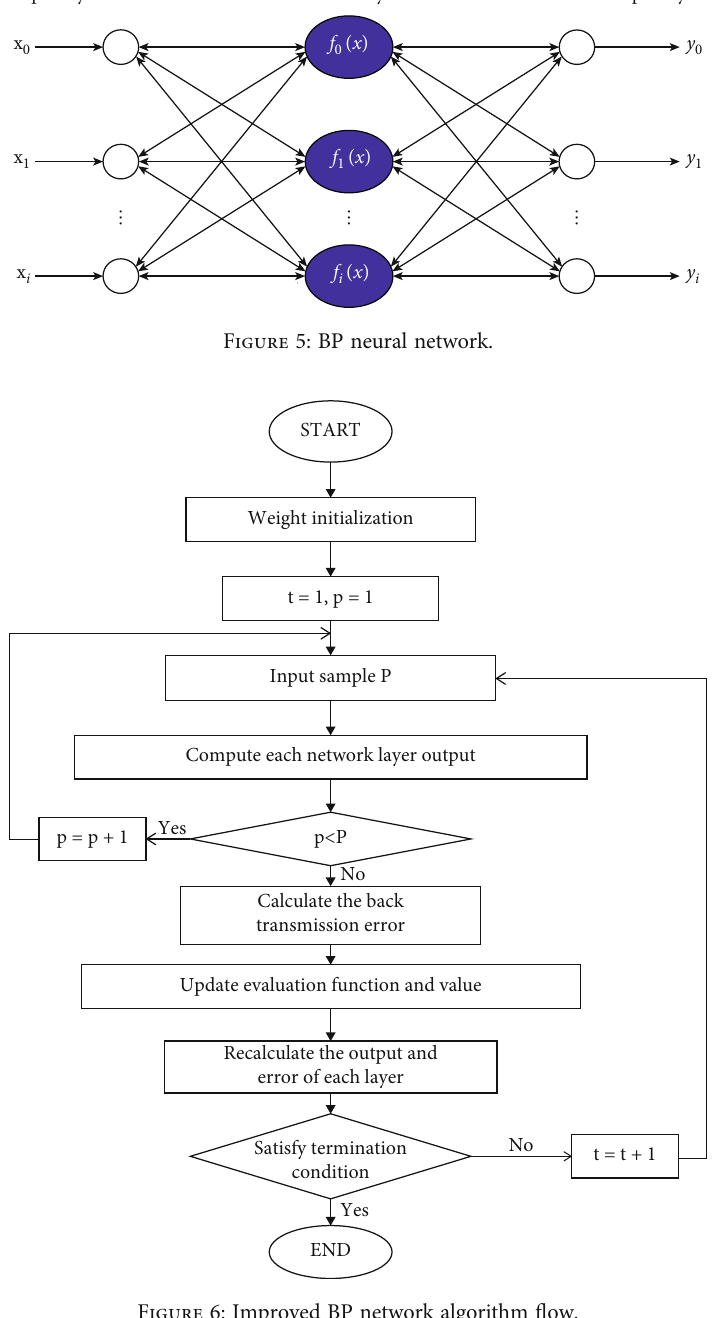
Figure 6: Improved BP network algorithm fl